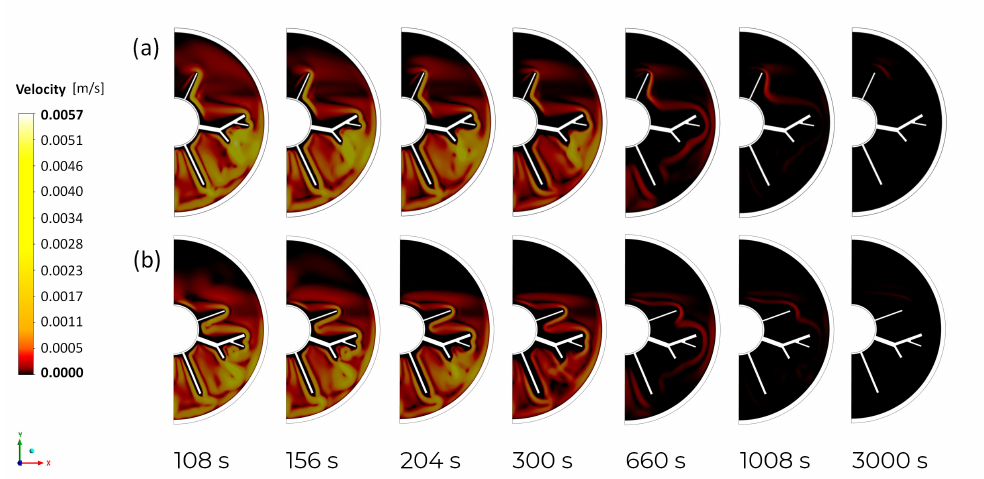
Figure 11. Contours of and streamlines during solidification for ( a ) DP No. 15, ( b ) DP No.